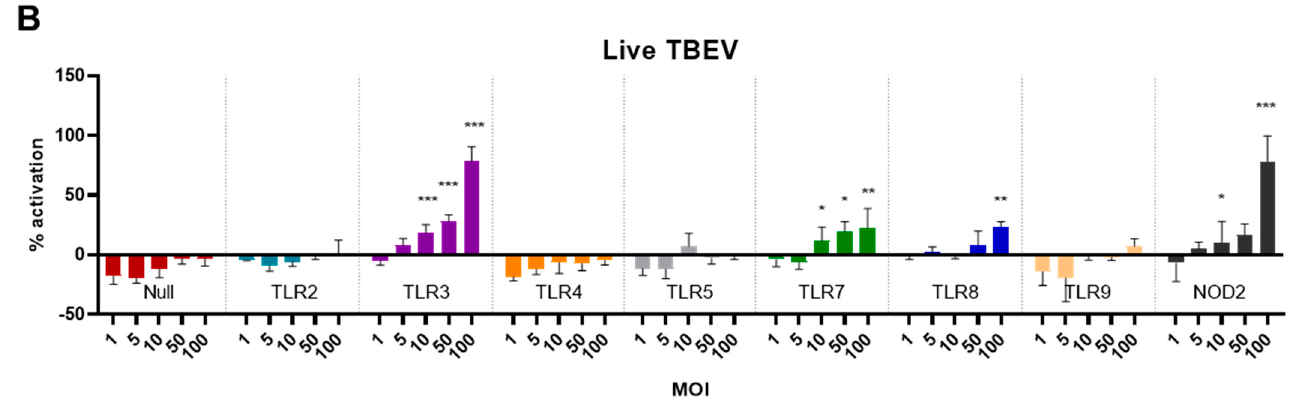
Figure 5. Activation of HEK Blue reporter cells by I-TBEV and live TBEV. ( A ) HEK Blue cells were stimulated with the indicated amounts of I-TBEV for 48 h at different concentrations. Subsequently, supernatants were added to the detection medium for assessment of NF- κ B-induced production of the reporter protein. The stimulation of the cells is presented as a percentage of activation relative to the activation achieved with 2.5 µ g/mL of TNF- α (set as 100%). Filled bars represent the responses to I-TBEV, empty bars responses to the matrix. ( B ) HEK Blue cells were stimulated with live TBEV virus for 48 h at the indicated multiplicity of infection (MOI), and activation was assessed as described above. Levels of significance: ns: p > 0.05; *: p ≤ 0.05; **: p ≤ 0.01 and ***: p ≤ 0.001 (compared to the level of activation in the Null cells stimulated with the same MOI). Results are from 3 replicates.